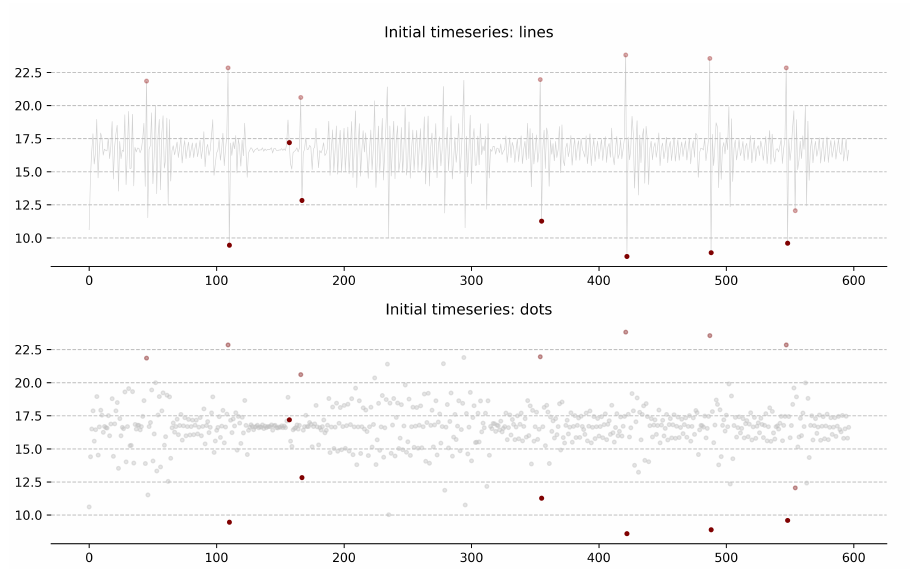
Figure 14. Numenta Anomaly Benchmark time series with zero-order trend and several spikes.